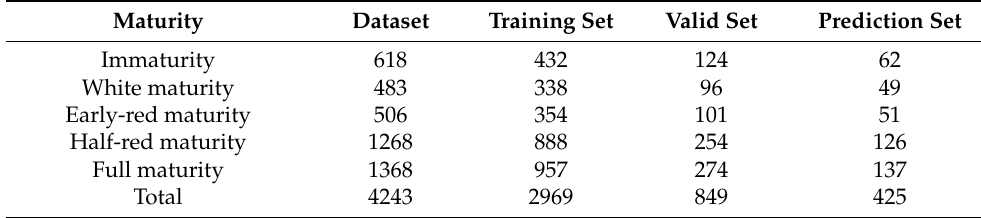
Table 1. Division of datasets.